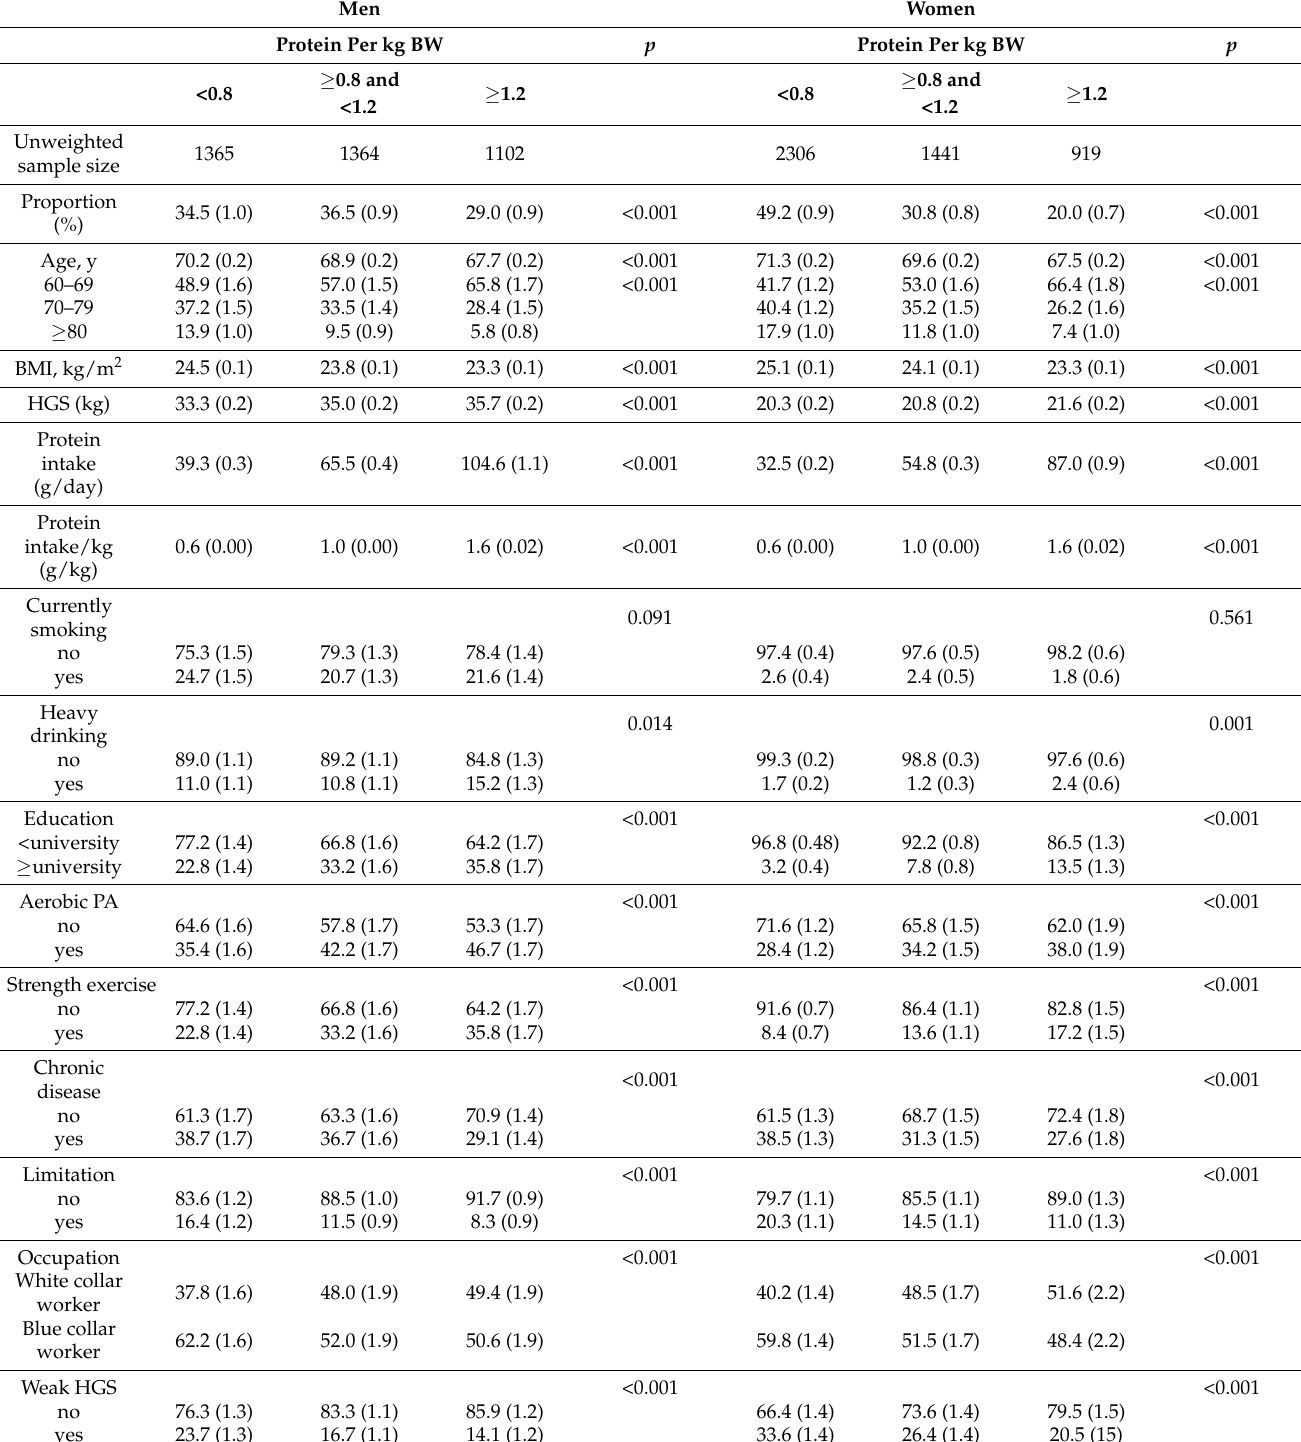
Table 1. Demographic characteristics of the participants according to protein intake